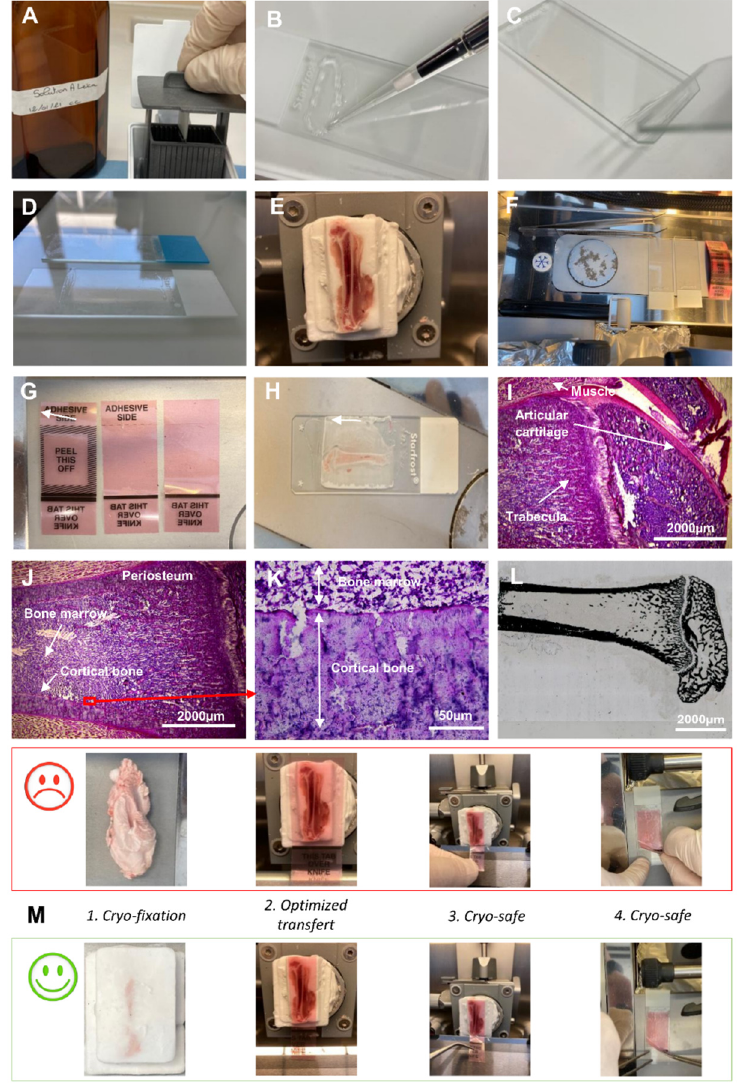
Figure 1. Cryo-fixation and cryo-section steps. Slides were manually coated with ( A ) A and ( B ) B buffer. ( C ) Thin B buffer layer on the slide surface. ( D ) Adjusted coating of the manually prepared slide compared with the manufactured one. ( E ) Entire cryo-embedded and trimmed femur of rat. ( F ) Cryo-bar to precool slides, adhesive film and tweezers. ( G ) Several surface size of adhesive film. ( H ) Thin (5 µ m) cryo-section of femur deposed on a pre-coated slide. ( I , J ) Histological coloration of femur stained with Hemalin–phloxine–saffron. ( K ) Expanded view: high magnification image of the area within the red rectangle in image ( J ). ( L ) Von Kossa staining of the mouse and rat bone. ( M ) Upper panel: technical practices to avoid; down panel: to improve the result in comparison with the appropriate